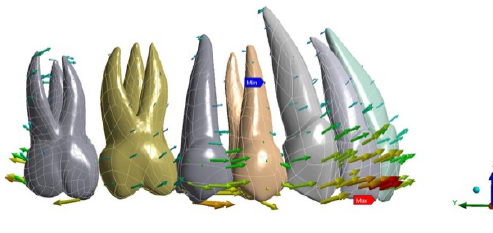
Figure 1. NO ATT tooth displacement.